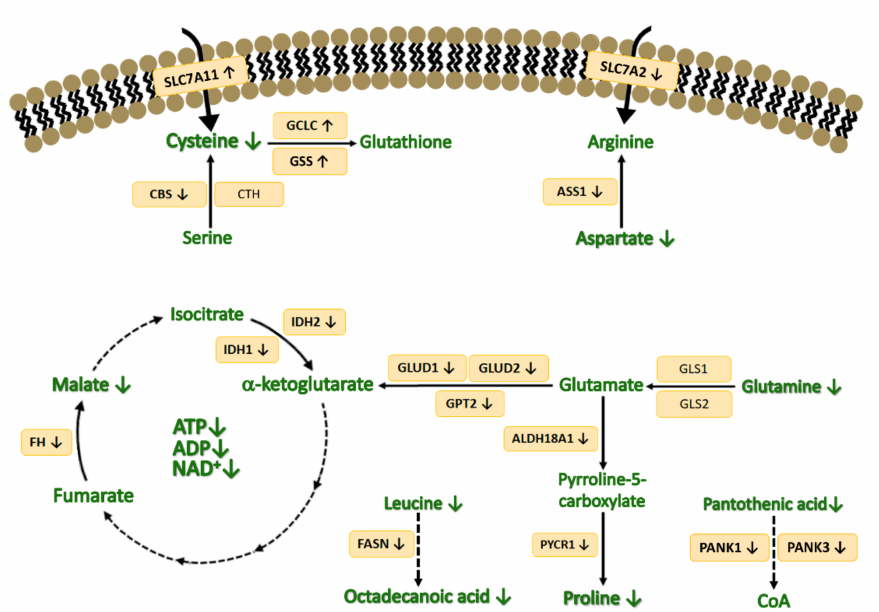
Figure 5. Illustration of the main metabolic reactions and pathways where the main impaired amino acids and TCA cycle intermediates found after AgNPs exposure take part.